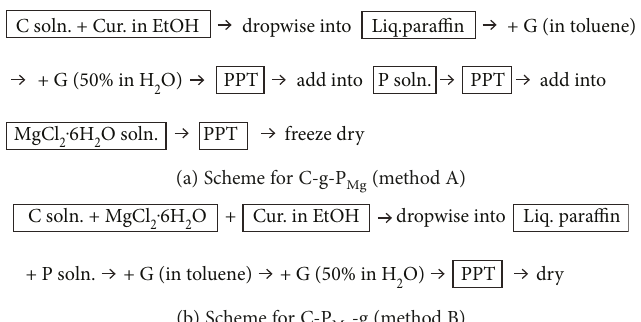
Figure 1: Fabrication schemes for (a) C-g-P PPT is precipitate.